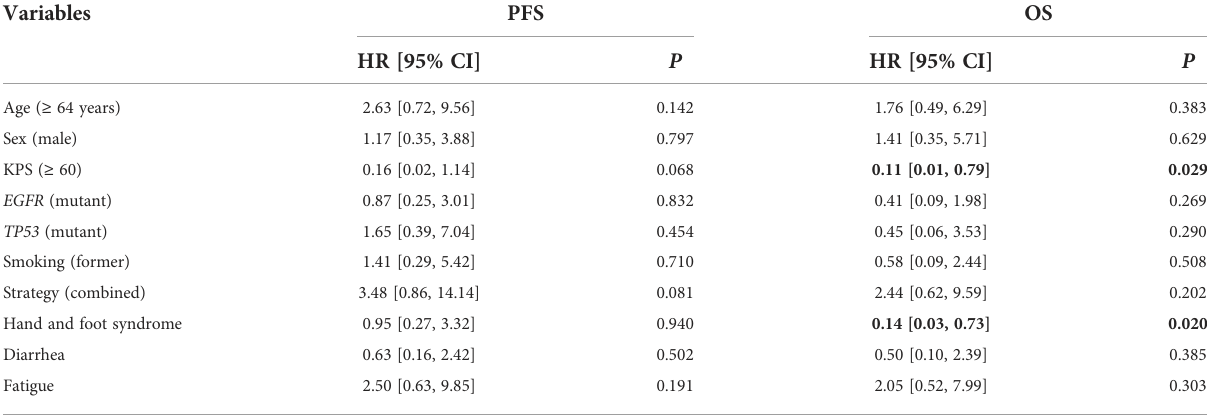
TABLE 3 Results of univariable COX regression analysis of risk factors for PFS and OS in 12 patients with adenocarcinoma treated with anlotinib.